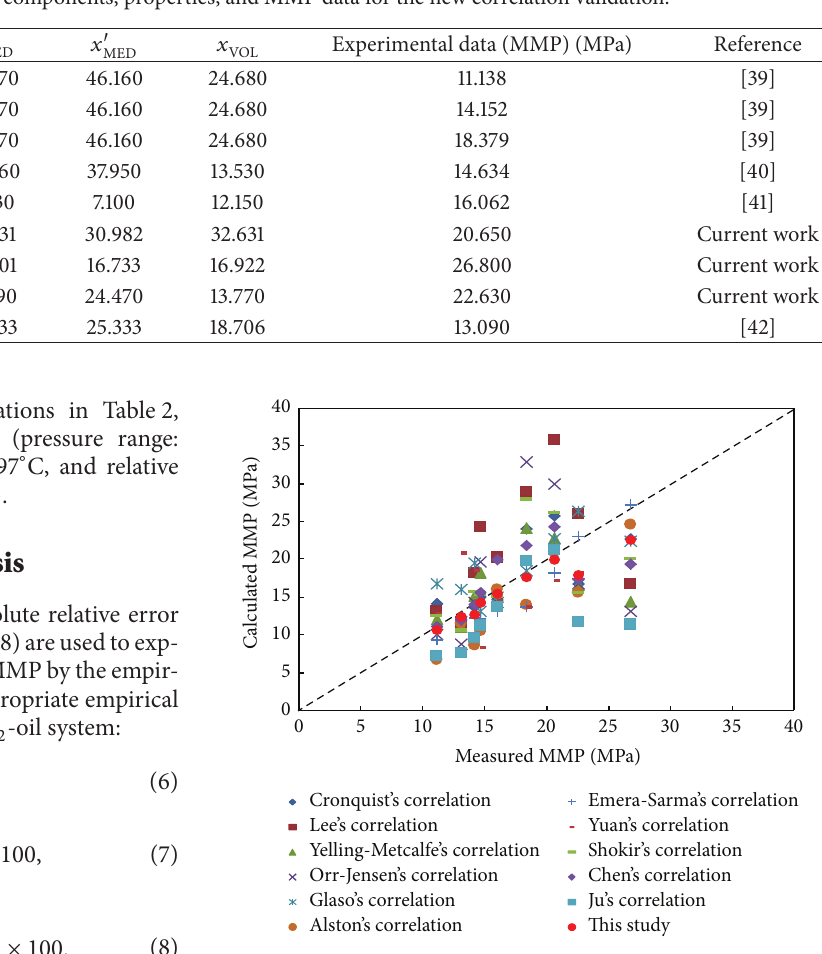
Figure 5: The resulted nine-oil-sample MMP from the new corre- lation proposed in this study versus the calculated nine-oil-sample MMP from Cronquist’s correlation, Lee’s correlation, Yelling- Metcalfe’s correlation, Orr-Jensen’s correlation, Glaso’s correlation, Alston’s correlation, Emera-Sarma’s correlation, Yuan’s correlation, Shokir’s correlation, Chen’s correlation, and Ju’s correlation.